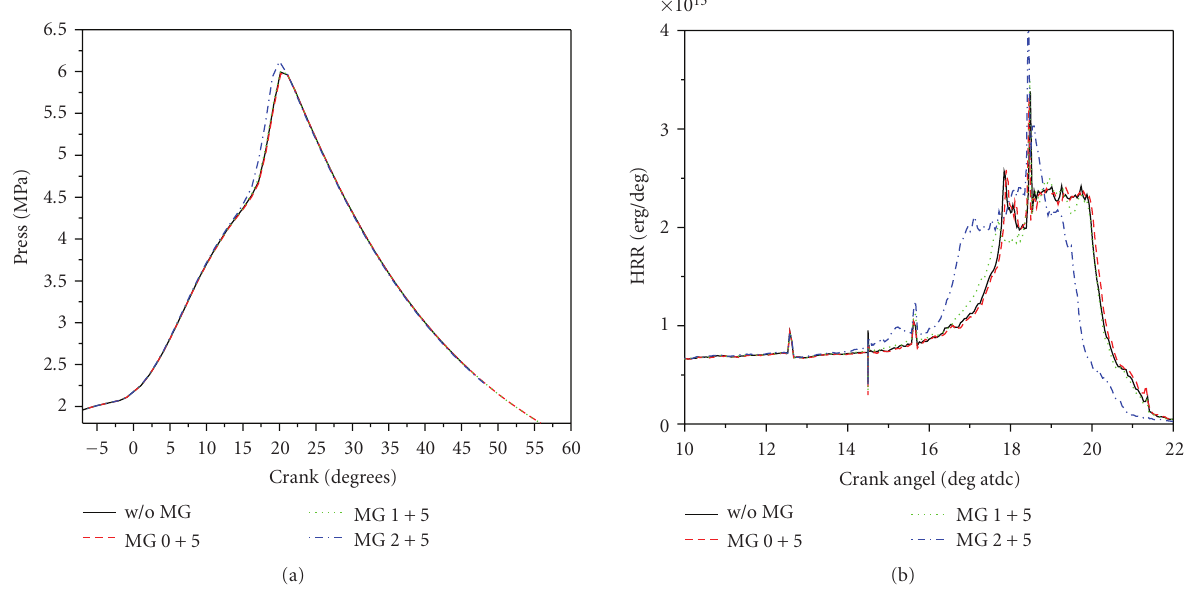
Figure 5: Pressure and HRR of SI engine simulated using two-zone MG model with di ff erent searching levels.